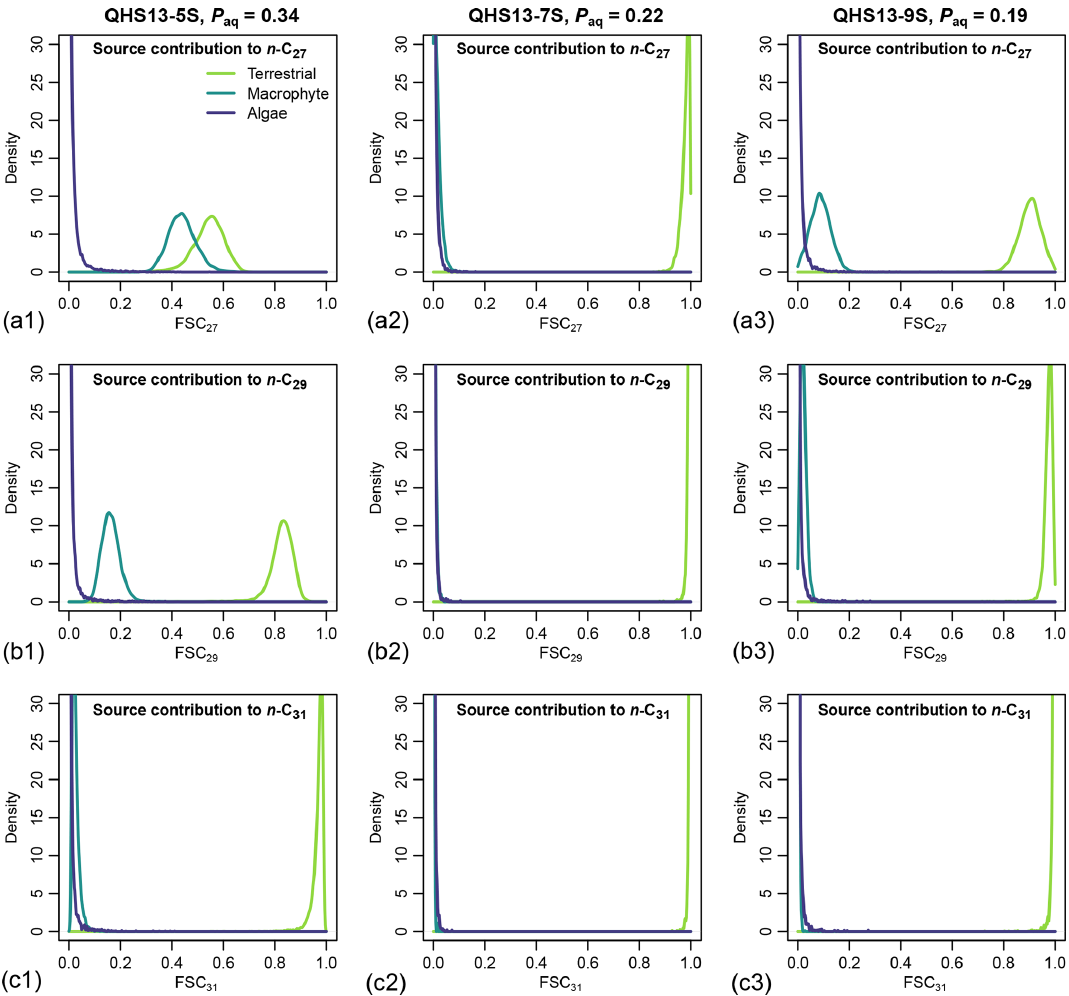
Figure 7. Posterior densities of fractional source contribution (FSC n ) of terrestrial plants, aquatic macrophytes, and algae to each specific alkane chain ( n -C 27 , n -C 29 and n -C 31 ) in published lake surface sediment samples from Lake Qinghai (Liu et al.,